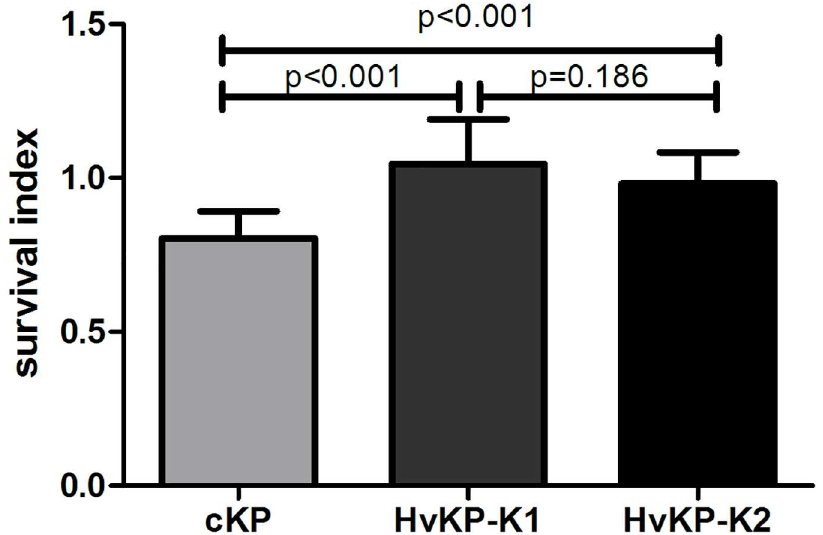
Fig 2. Survival of cKP, HvKP-K1 and HvKP-K2 within human neutrophils. The survival index was calculatedwith the equationdescribedin the method. The survival index of cKP (15 isolates) was lower than that of HvKP-K1 (16 isolates)or HvKP-K2 (14 isolates). Each strain was repeatedtwice and averaged.Then the mean ± standarddeviation(S.D.) of each group was calculated.Statistics was performed using one-way analysisof variance.Differencesbetweengroups were assessedby t test. HvKP-K1 vs. cKP or HvKP-K2 vs. cKP: p <